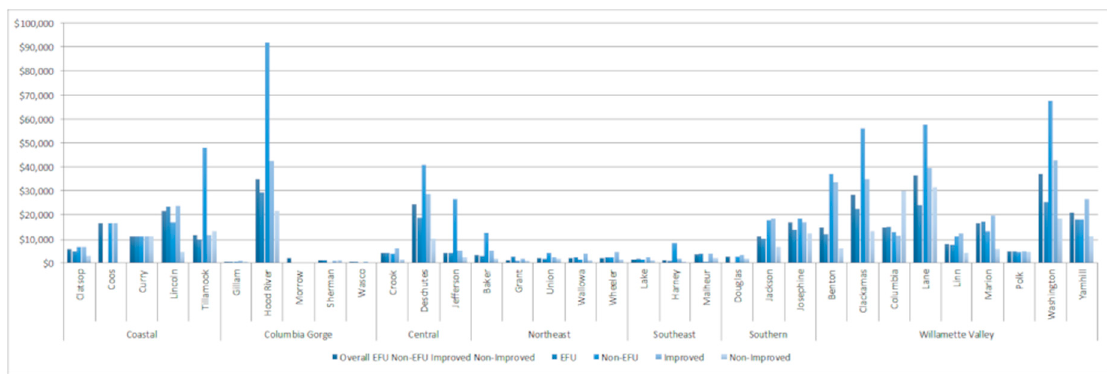
Figure 3. ( a ) Price per acre of non-EFU-zoned farmland, by county. ( b ) Price per acre of EFU-zoned farmland, by county.